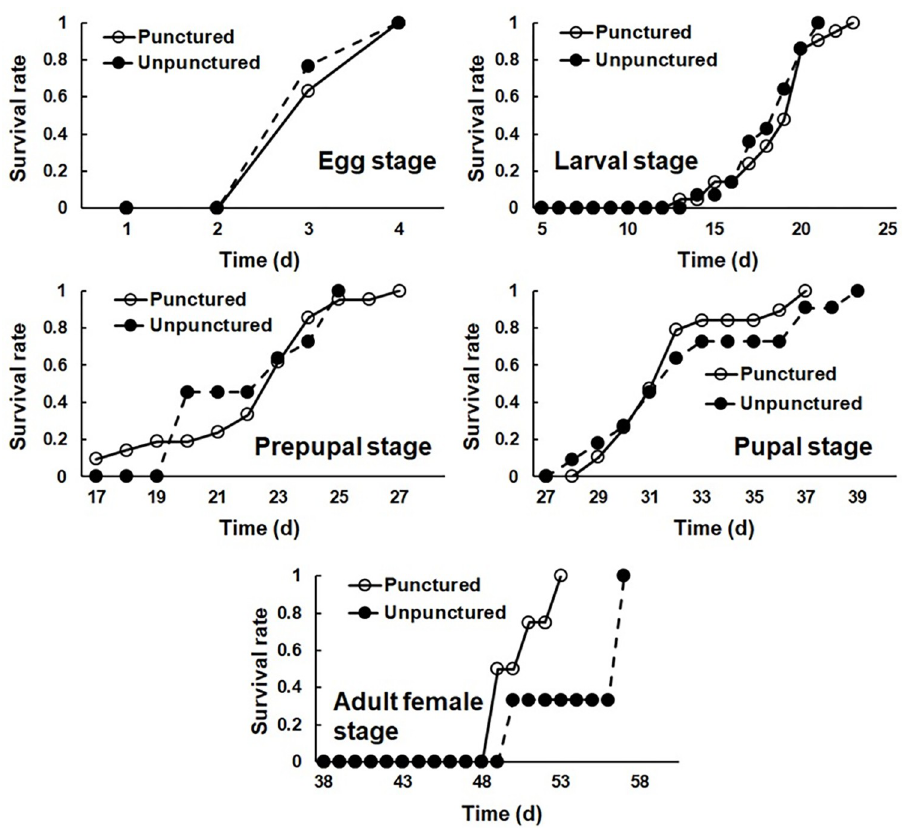
Fig 1. Survival rate of different life stages of Grapholita molesta reared on punctured and unpunctured apples.